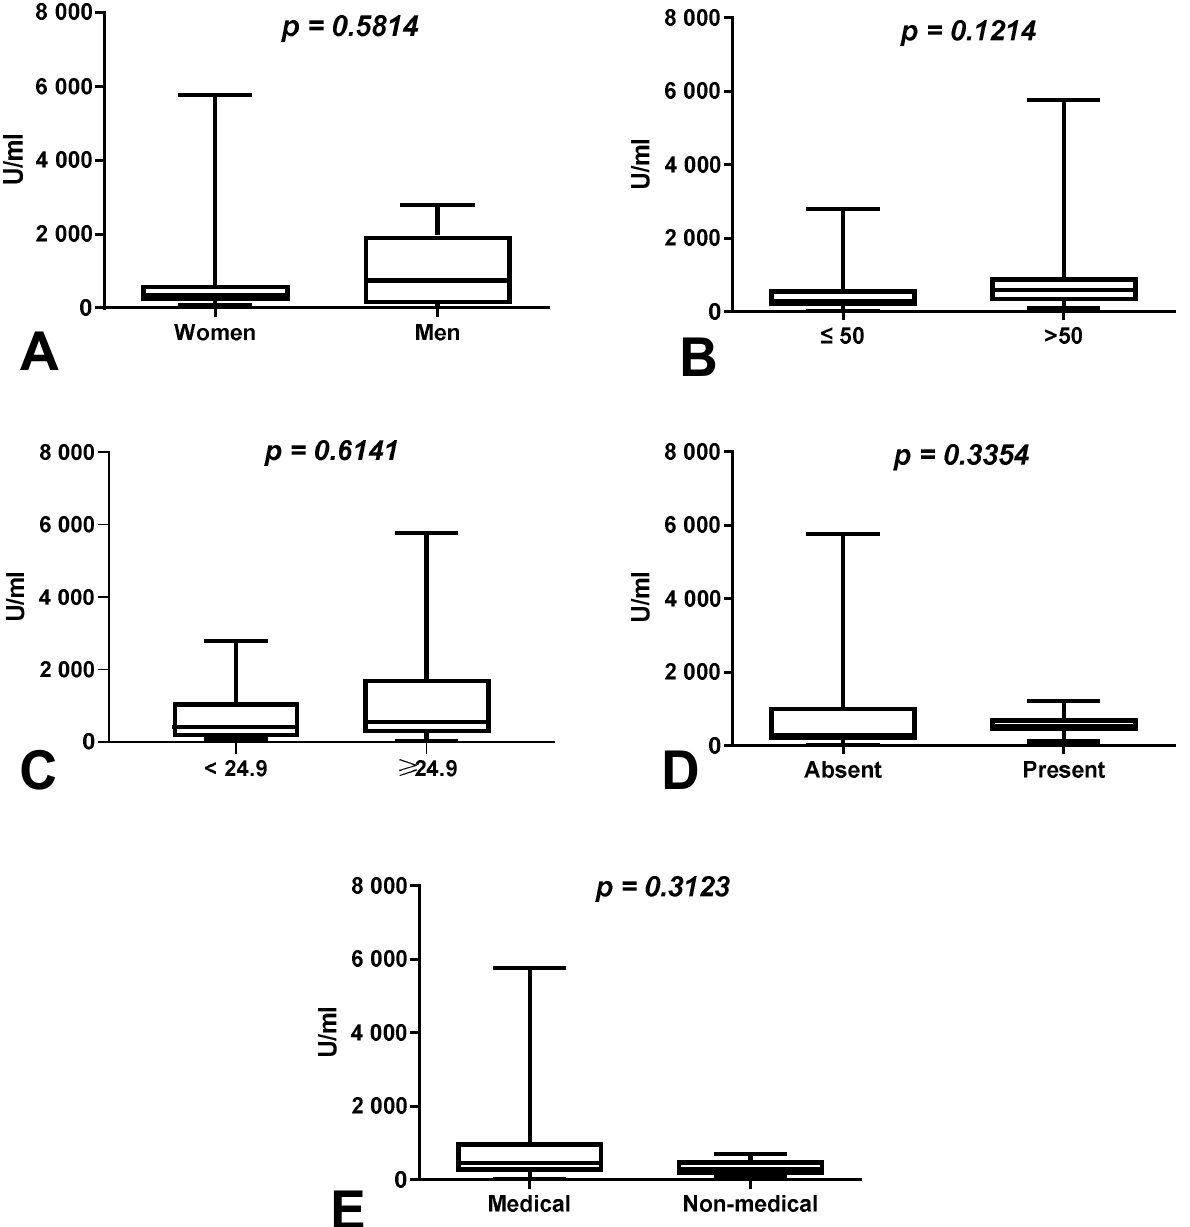
Figure 1. ( A ) Comparison of difference in total anti-SARS-CoV-2 antibody levels between first (after 8 months) and second determination (after 10 months) in the groups of women and men with a history of COVID-19. The data are presented as median (minimum–maximum). ( B ) Comparison of difference in total anti-SARS-CoV-2 antibody levels between first and second determination in the groups of patients over and under the age of 50 with a history of COVID-19. The data are presented as median (minimum–maximum). ( C ) Comparison of difference in total anti-SARS-CoV-2 antibody levels between first and second determination in the group of patients with normal and increased BMI with a history of COVID-19. The data are presented as median (minimum–maximum). ( D ) Comparison of difference in total anti-SARS-CoV-2 antibody levels between first and second deter- mination in the groups of patients with and without coexisting diseases with a history of COVID- 19. The data are presented as median (minimum–maximum). ( E ) Comparison of difference in total anti-SARS-CoV-2 antibody levels between first and second determination in the groups of medical and non-medical workers with a history of COVID-19. The data are presented as median (mini- mum–maximum).